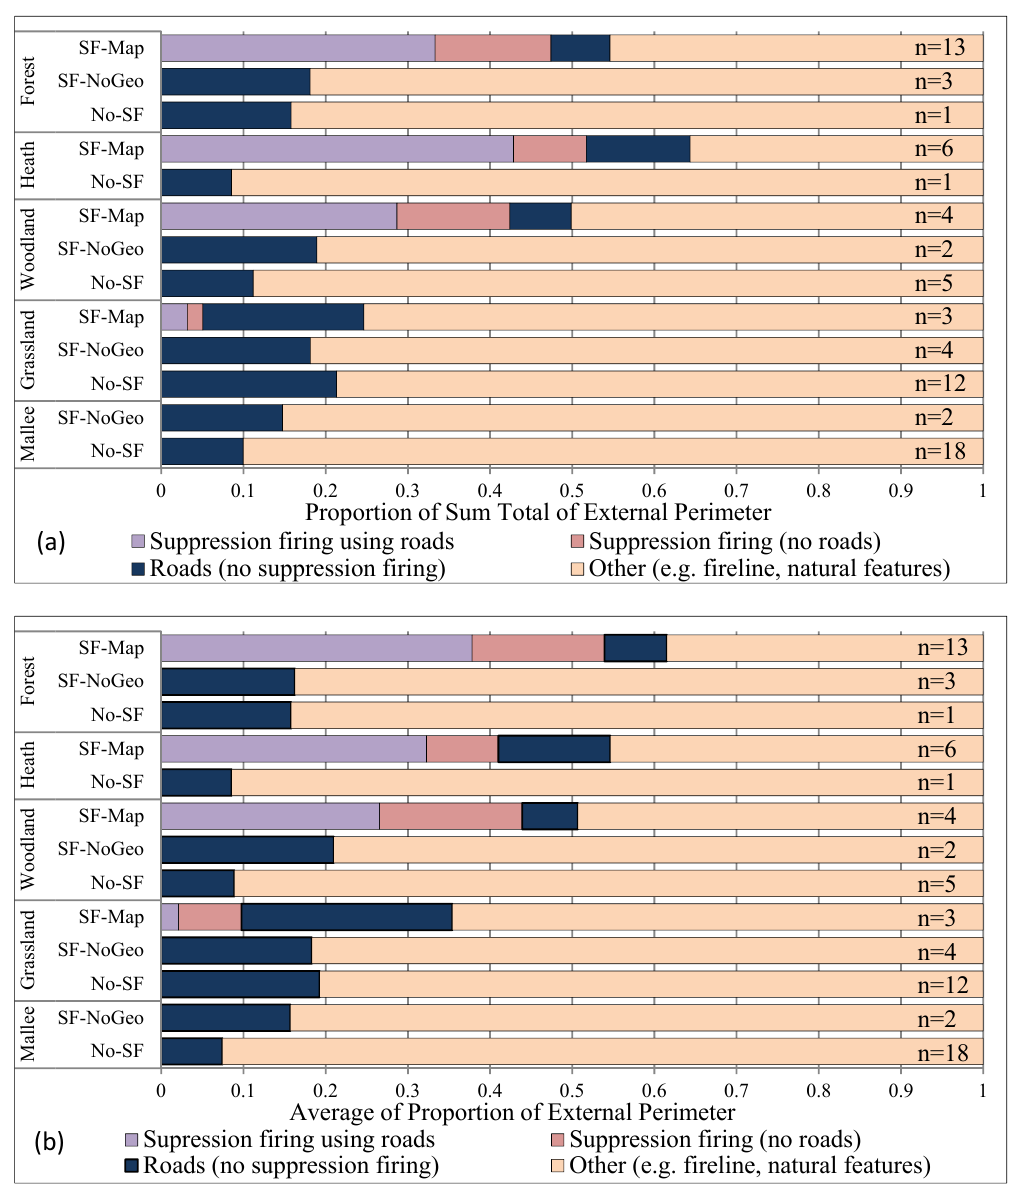
Figure 3. Proportional containment: the proportion of external fire perimeter that was contained by roads, suppression firing (either along the road or not), or other features. As there is a wide range (1–100%) in the proportion of external fire perimeter contained by suppression firing, we present two graphs. ( a ) The top graph is proportioning the total perimeter of all the fires. ( b ) The bottom graph is an average of the proportions for each fire. Fires are grouped by dominant fuel type (forest, heath, woodland, grassland, mallee). SF-Map fires had mapped suppression firing. SF-NoGeo fires did not have enough geographic data to map the suppression firing that was indicated in the SitReps. No-SF had no evidence of suppression firing.